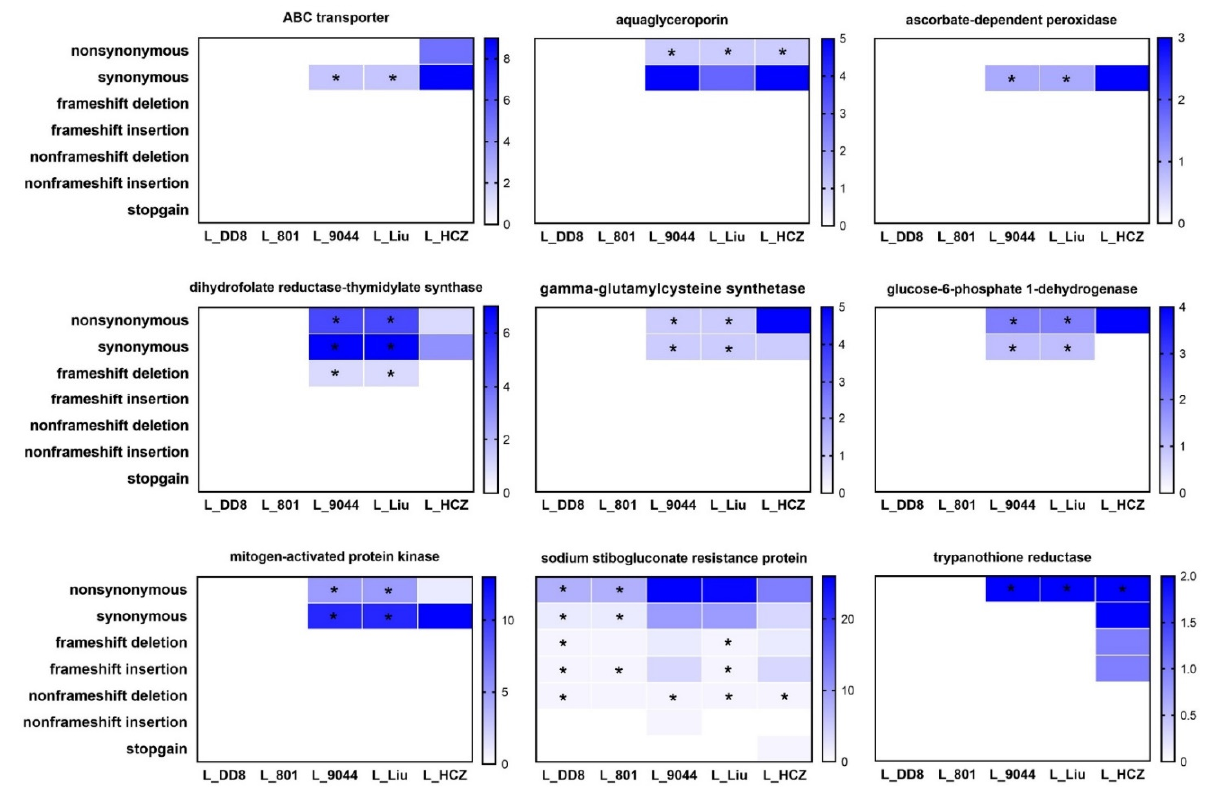
Figure 7. Mutation analysis of antimony resistance-related genes in five Leishmania isolates. * Means that in this type of mutation, the gene sites, numbers and bases of mutations in different Leishmania isolates were completely consistent.